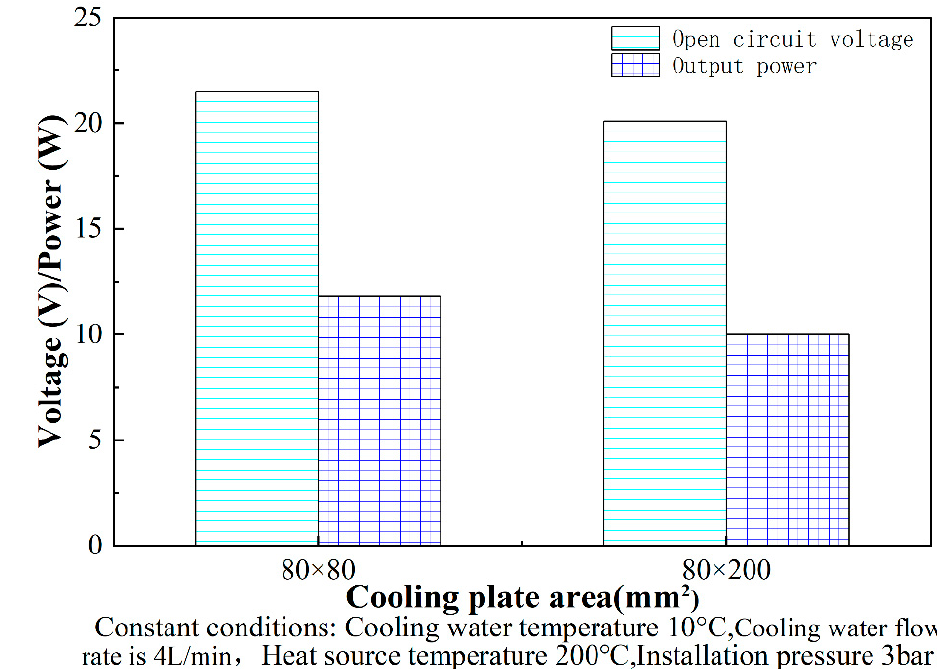
Figure 9. Effect of cooling plate area on open-circuit voltage and output power.